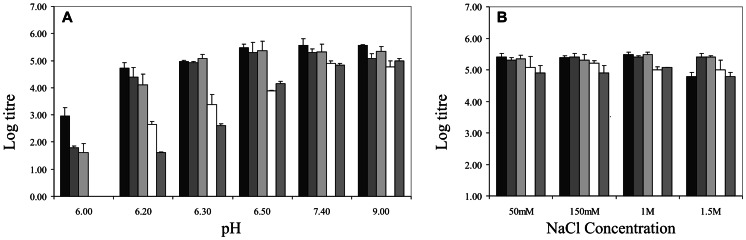
pH and ionic strength stability profiles of vSAT2 (black), vSAT2ZIM14-SAT2 (dark grey), vSAT2ZIM17-SAT2 (light grey), vSAT2ZAM7-SAT2 (white) and vSAT3ZAM4-SAT2 (medium grey).(A) Inactivation of SDG-purified virus particles following treatment with TNE (100 mM Tris, 150 mM NaCl, 10 mM EDTA) buffers ranging from pH 9.0 to 6.0 for 30 min. The average virus titers of two inactivation experiments at each pH are plotted. (B) The viruses were incubated in buffers with varying NaCl concentrations and the average log titers of two experiments are plotted.